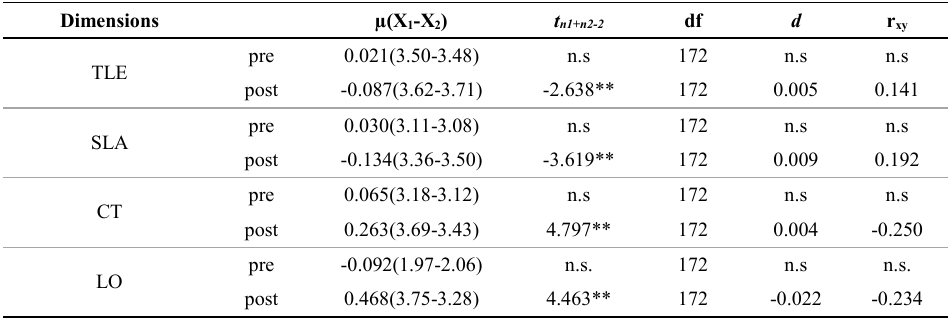
Table 2. Study of the value of independence between independent samples with pretest and posttest. Student T for independent samples